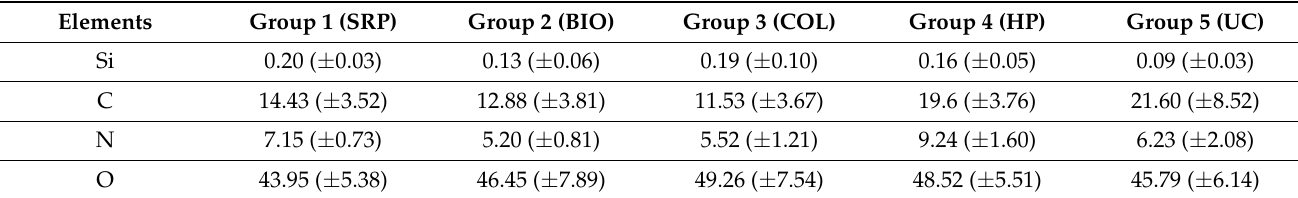
Table 4. Elemental composition (atomic %, Mean ± SD) for each group after 45 days using